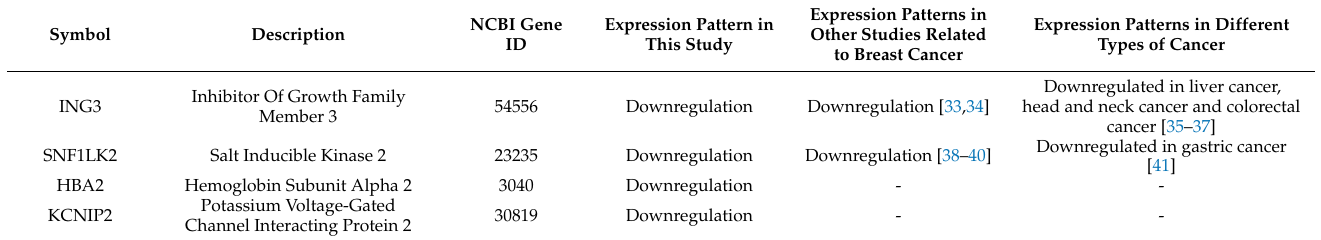
Table 3. Comparison of expression patterns of the selected 20 DE mRNAs with the results of this study and other tumor